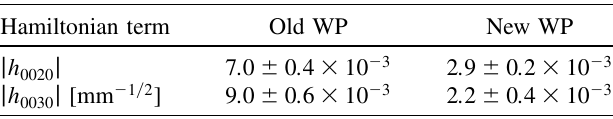
TABLE VI. Comparison of the bare machine resonance exci- tation for the old and new working point. Hamiltonian